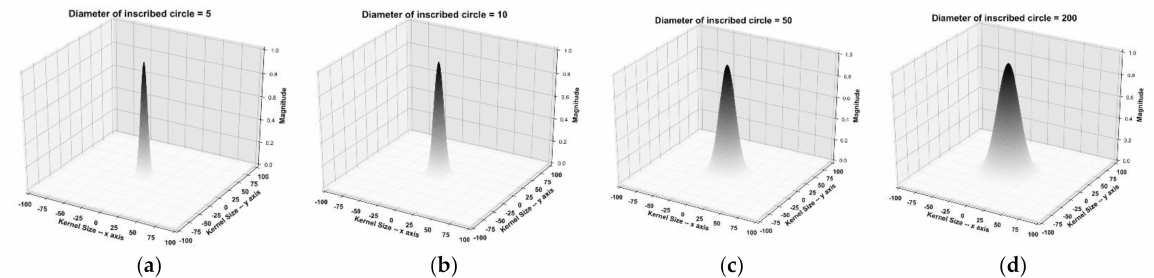
Figure 6. Schematic diagram of positive sample expansion area under five different ground-truth bounding box sizes. Subfigures ( a – d ) represent the corresponding dense prediction regions under different inscribed circle